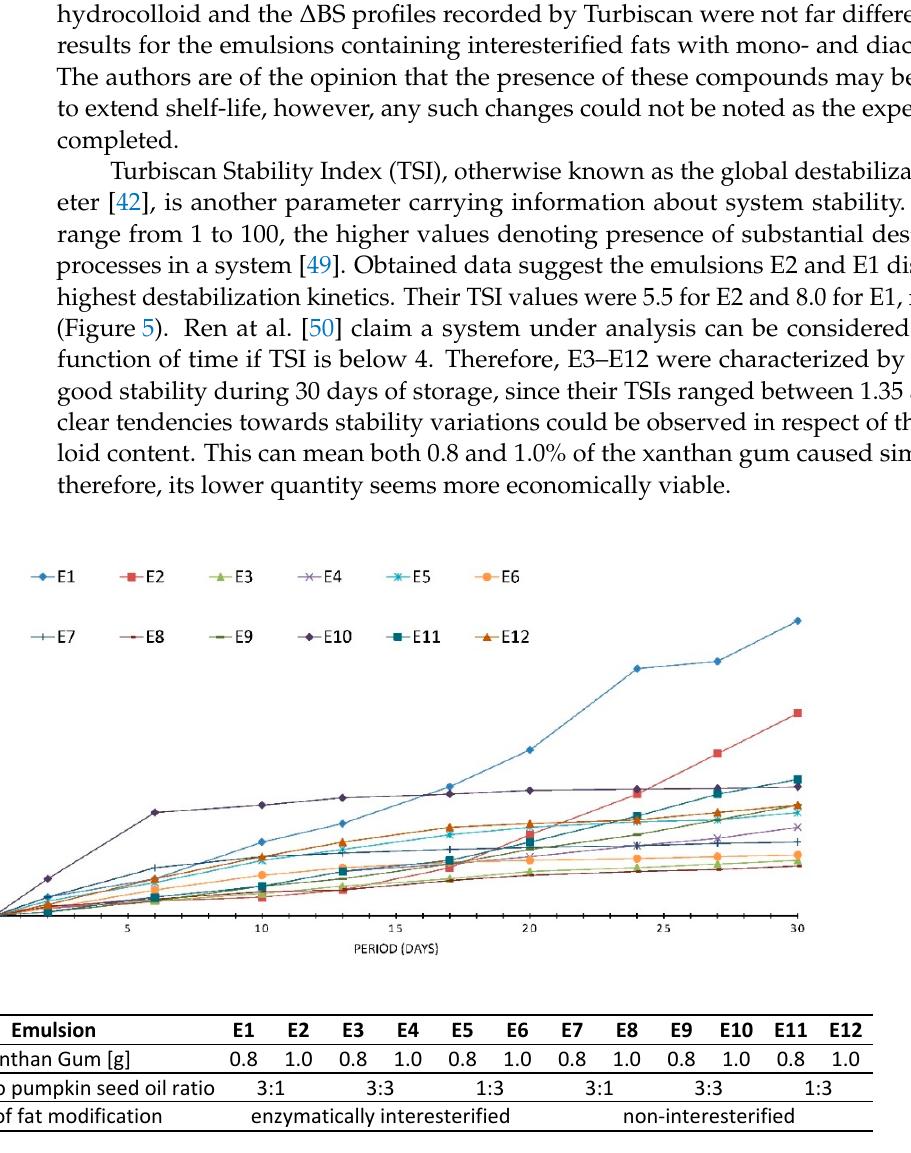
Figure 5. TSI values of emulsions E1–E12 during 30 days of storage. Each point corresponds to subsequent measurements performed in 3–4 days intervals.